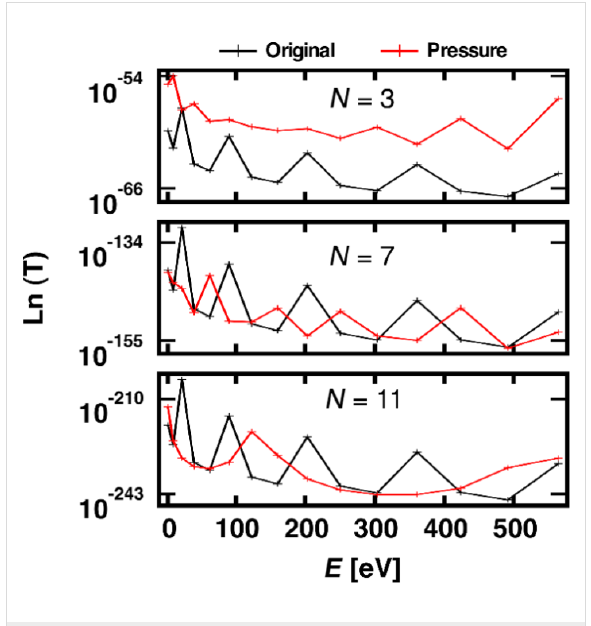
Figure 7: Transmission probability for a multibarrier system for the energy levels of the PCEO model. Three different numbers of barriers are shown ( N = 3, 7 and 11) for the first 15 wave numbers (energy levels). “Original” (black curves) refers to the untreated coating, where the distance between barriers is 2 nm. “Pressure” (red curves) refers to the reduced inter-barrier distance following the high-pressure treat-